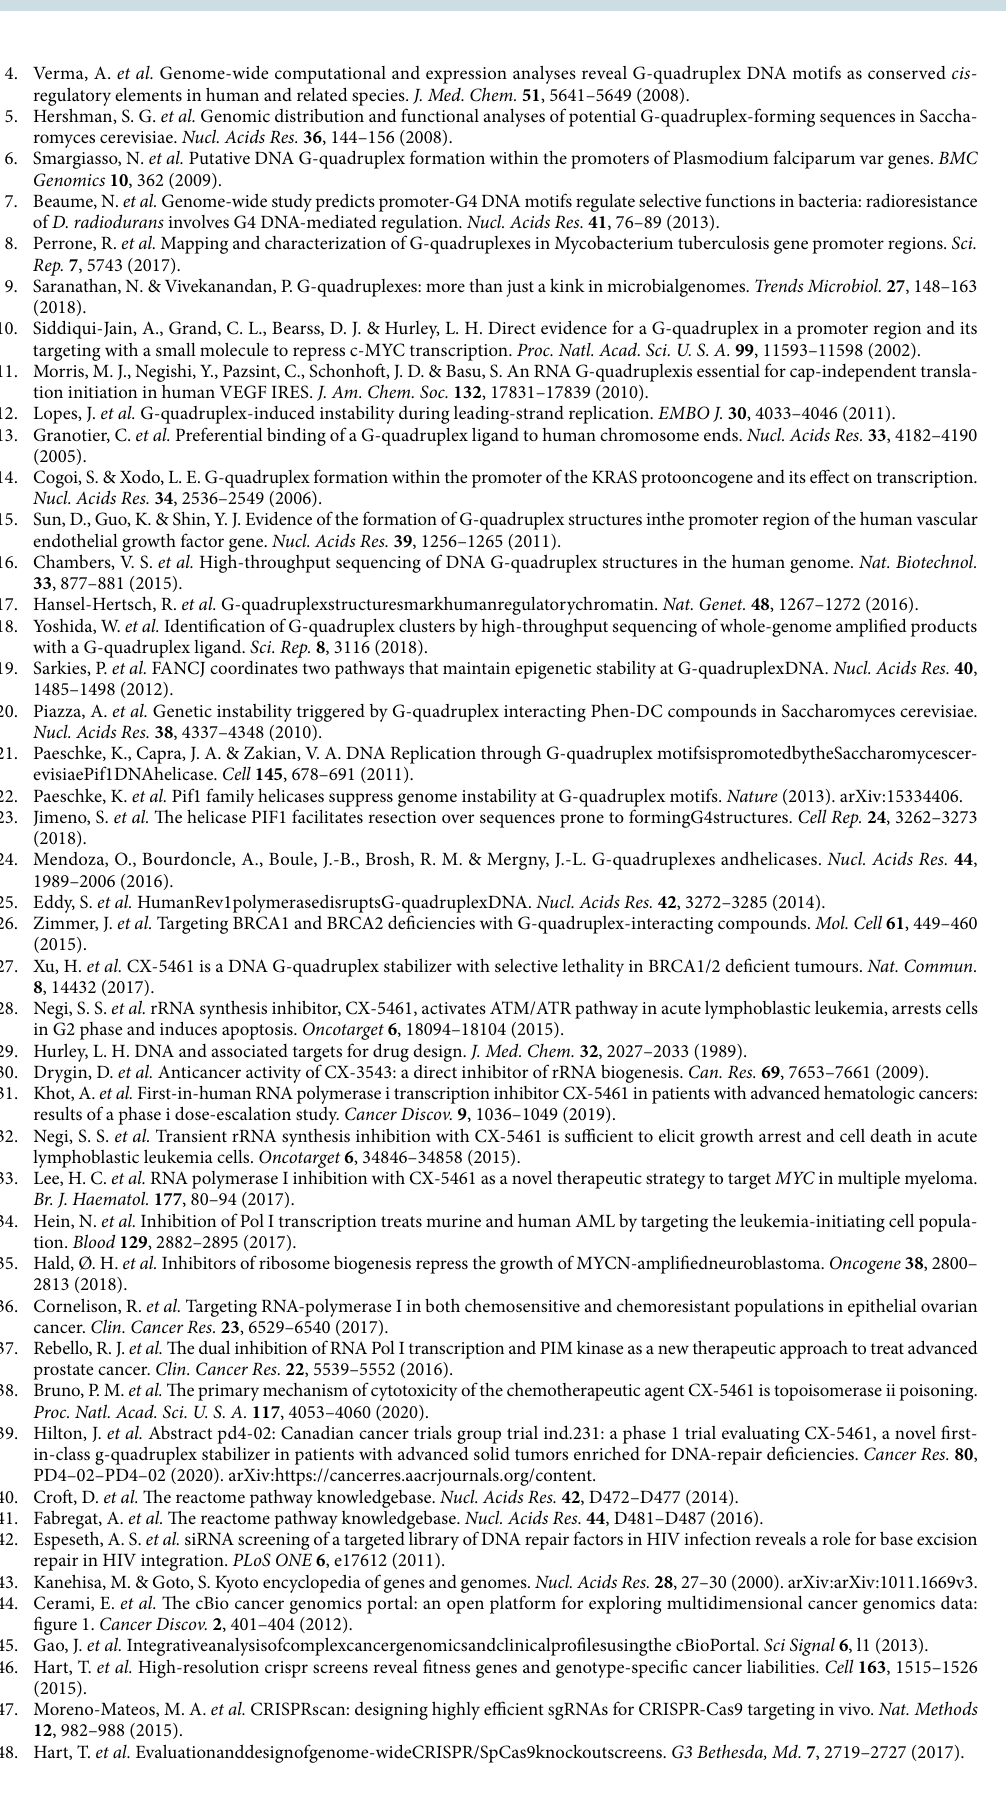
figure 1. Cancer Discov. 2 , 401–404 (2012). 45. Gao, J. et al. Integrativeanalysisofcomplexcancergenomicsandclinicalprofilesusingthe cBioPortal. Sci Signal 6 , l1